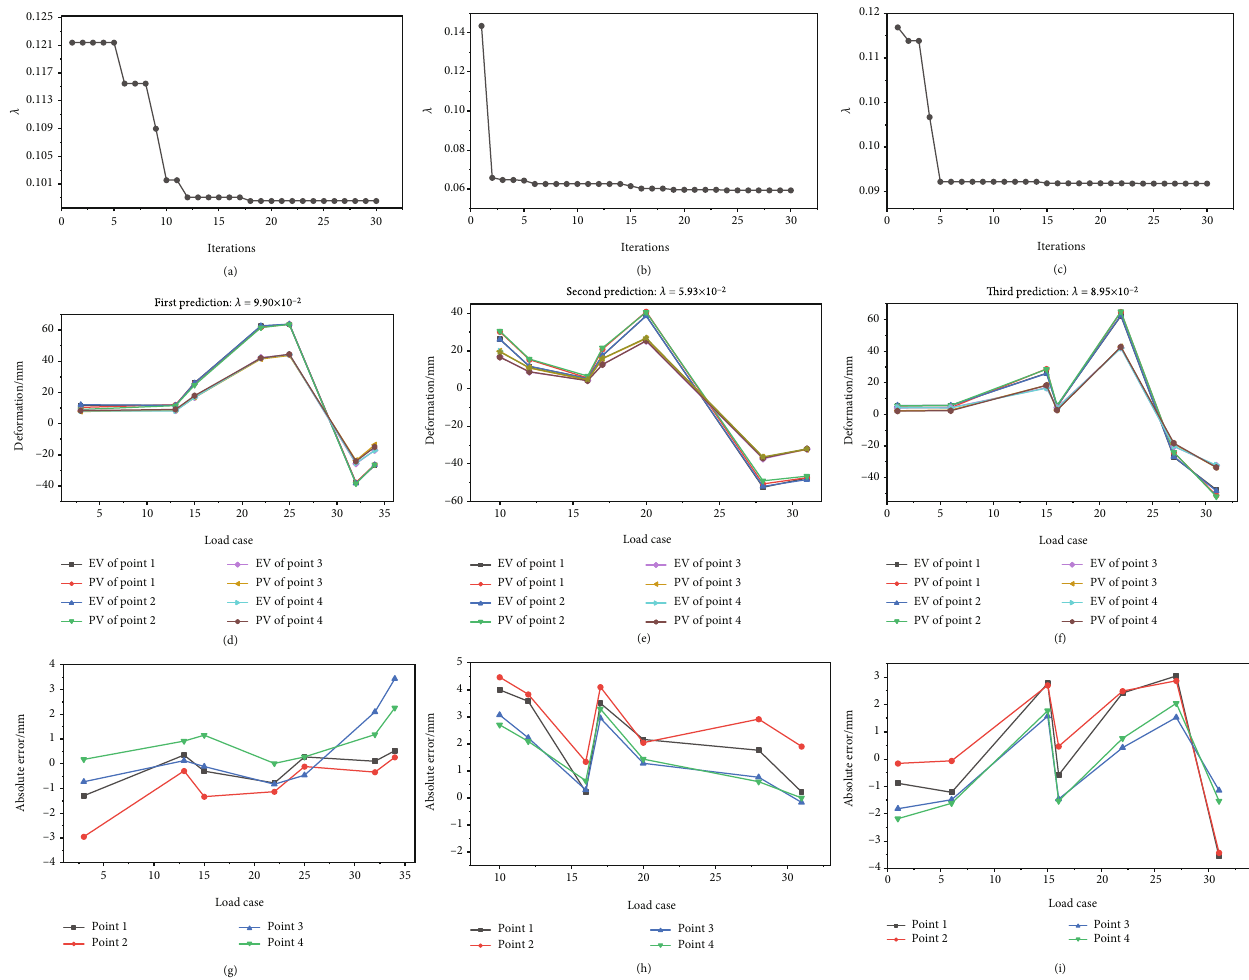
Figure 12: Predicted and exact values of displacement of the PSO-RR method.